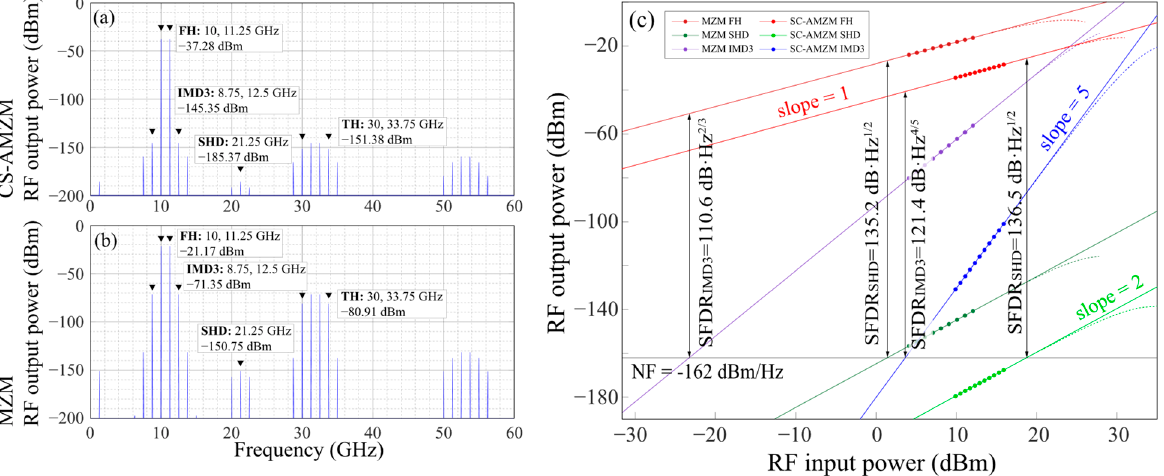
Figure 11. Spectrogram of ( a ) CS-AMZM and ( b ) MZM with losses and deviations. ( c ) Simulated SFDR results of the standard MZM and the proposed CS-AMZM. The dashed line shows the actual output power for large input power.